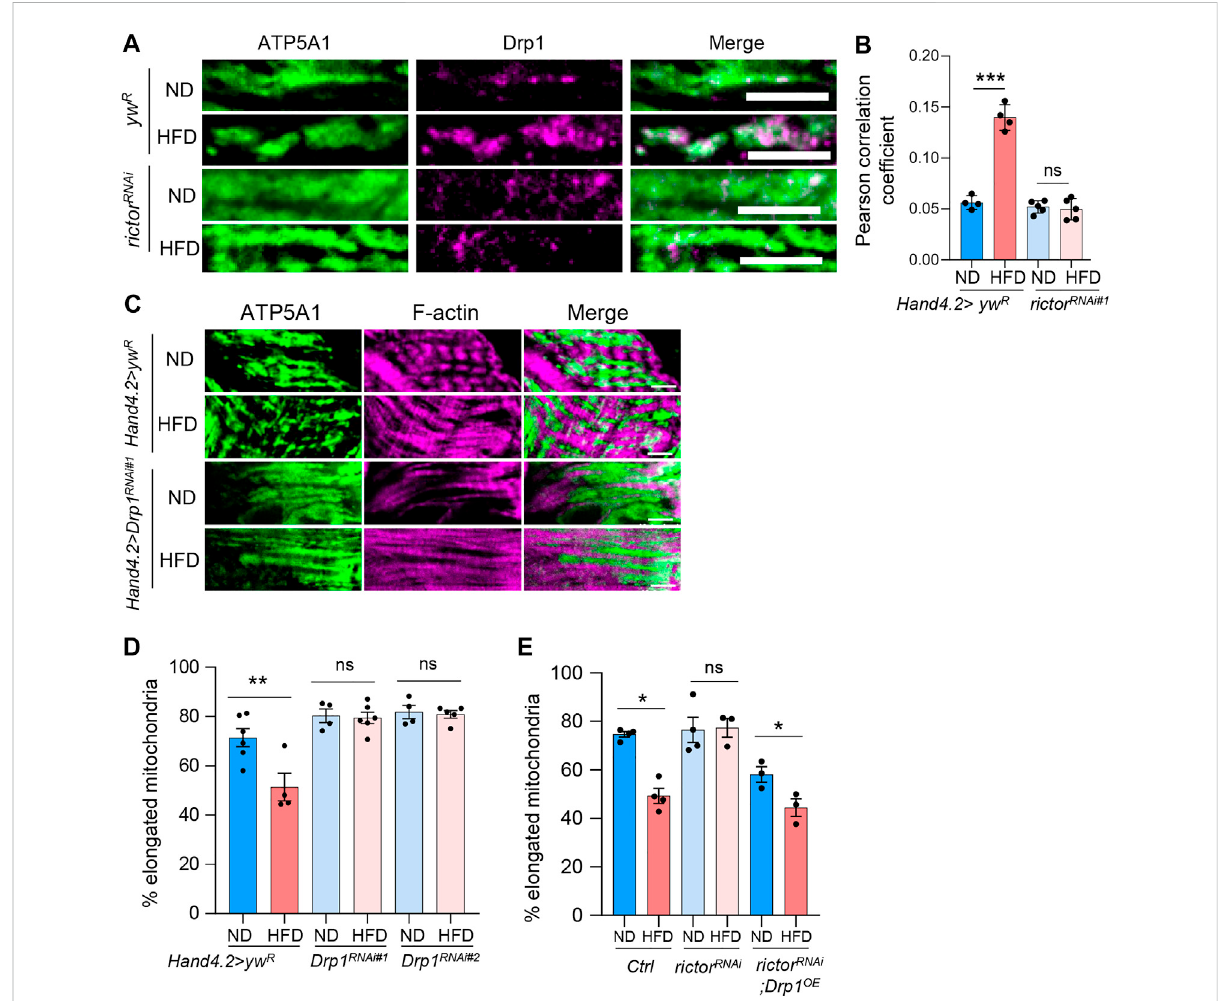
FIGURE 4 Rictor controls HFD-induced mitochondrial localization of Drp1. (A) Immunostaining of mitochondrial localization of Drp1 protein in cardiomyocytes of ND- or HFD-treated control and rictor knockdown fl ies. Scale bar: 10 μ m. (B) The quanti fi cation of Pearson correlation coef fi cient of the colocalization between Drp1 and mitochondrial marker (ATP5A1). Two-way ANOVA: Interaction between diet and genotype is highly signi fi cant, p < 0.0001. Tukey ’ s multiple comparison test: *** p < 0.001, ns: not signi fi cant. N = 4~5 (4~5 hearts per genotype). (C) Immunostaining of mitochondria and F-actin of cardiomyocytes from ND- or HFD-treated control and Drp1 knockdown fl ies. Scale bar: 10 μ m. (D) The proportion of the elongated mitochondria of the control and Drp1 knockdown fl ies under ND or HFD treatment. Two-way ANOVA: Interaction between diet and genotype is signi fi cant, p = 0.0098. Tukey ’ s multiple comparison test: ** p < 0.01, ns: not signi fi cant. N = 4~6 (4~6 hearts per genotype). The control group re-uses the data from Figure 1F. (E) The proportion of the elongated mitochondria of the control, rictor knockdown, and rictor RNAi ; Drp1 OE fl ies under ND or HFD treatment. Two-way ANOVA: Interaction between diet and genotype is signi fi cant, p = 0.0072. Tukey ’ s multiple comparison test: * p < 0.05, ns: not signi fi cant. N = 3~4 (3~4 hearts per